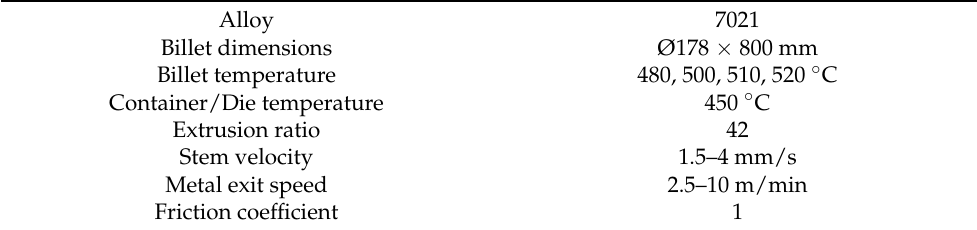
Table 4. All the defined parameters of the FEM modelled extrusion process of tubes of Ø50 × 2 mm from 7021 alloy.